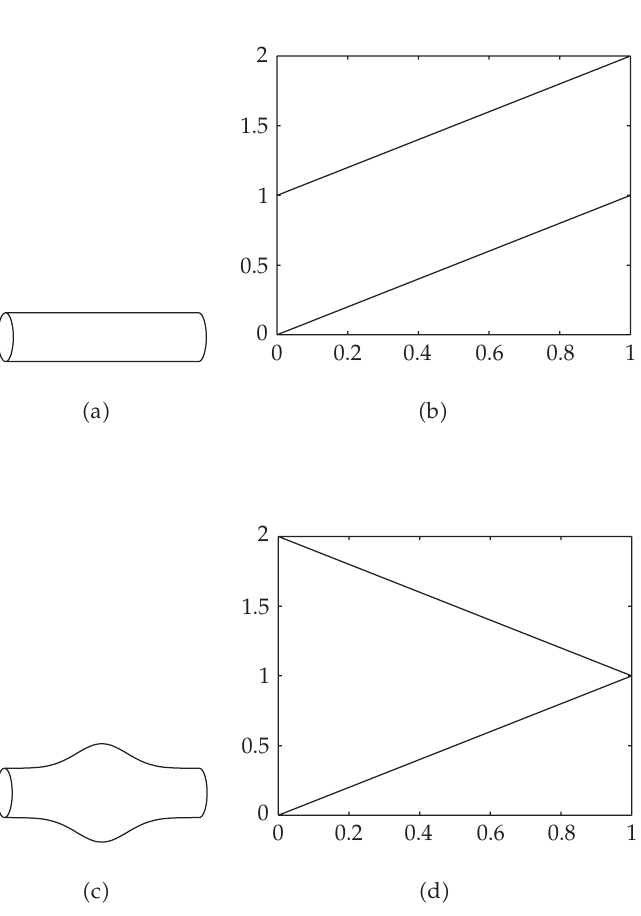
Figure 5.1 . Rod geometries and computational domains for the three inverse problems under consideration. ( a ) Rod geometry for the homogeneous rod and the rod with varying modulus. ( b ) Com- putational domain for the homogeneous rod, { ( x,t ) | 0 ≤ x ≤ 1 , x ≤ t ≤ x + 1 } . ( c ) Rod geometry for the rod with varying cross-sectional area. ( d ) Computational domain for the rod with varying cross- sectional area and the rod with varying modulus, { ( x,t ) | 0 ≤ x, x ≤ t ≤ 2 − x }